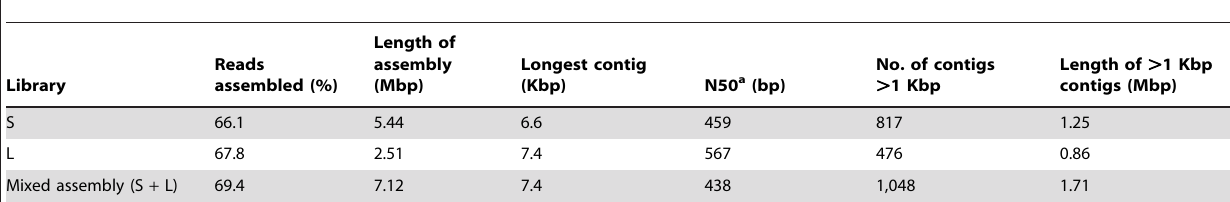
Table 4. Summary of MetaIDBA assemblies made with Illumina reads from wastewater metamobilomes.